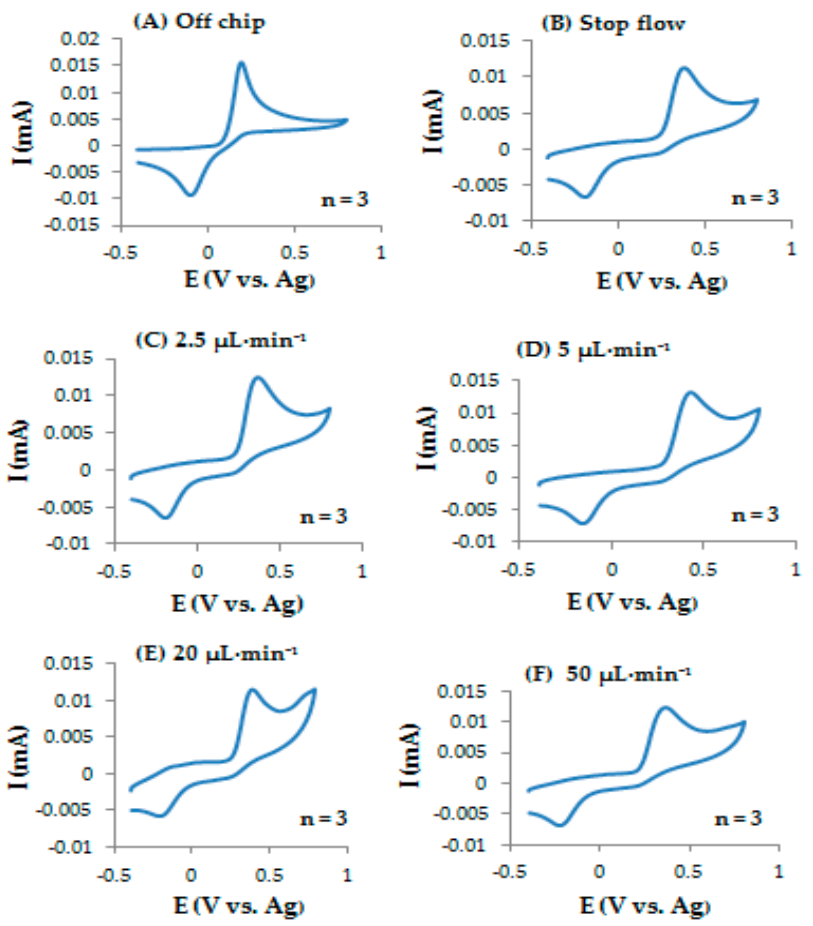
Figure 12. Cyclic voltammetry in the presence of APAP (1 × 10 − 3 M). ( A ) Off chip; ( B ) Stop flow; ( C ) 2.5 µL·min − 1 ; ( D ) 5 µL·min − 1 ; ( E ) 20 µL·min − 1 ; ( F ) 50 µL·min − 1 .